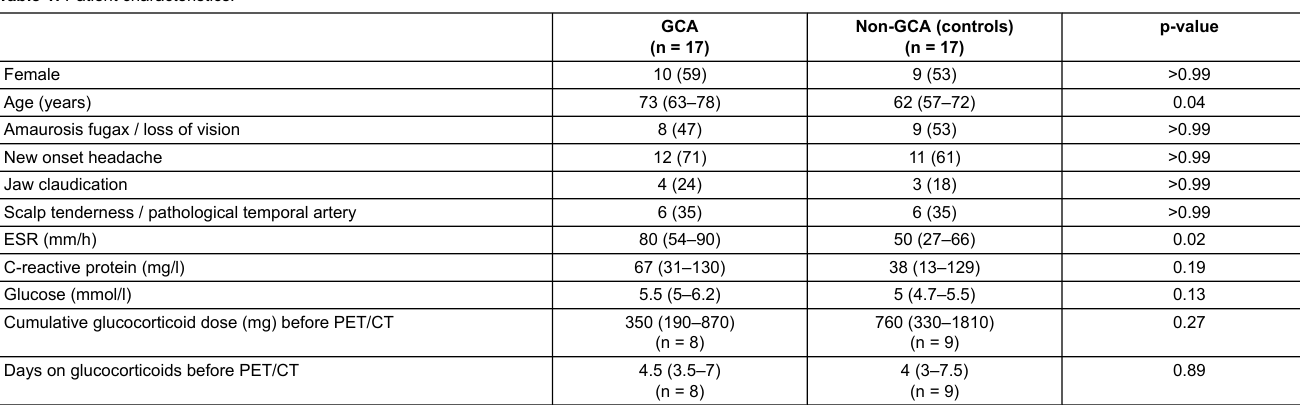
Table 1: Patient